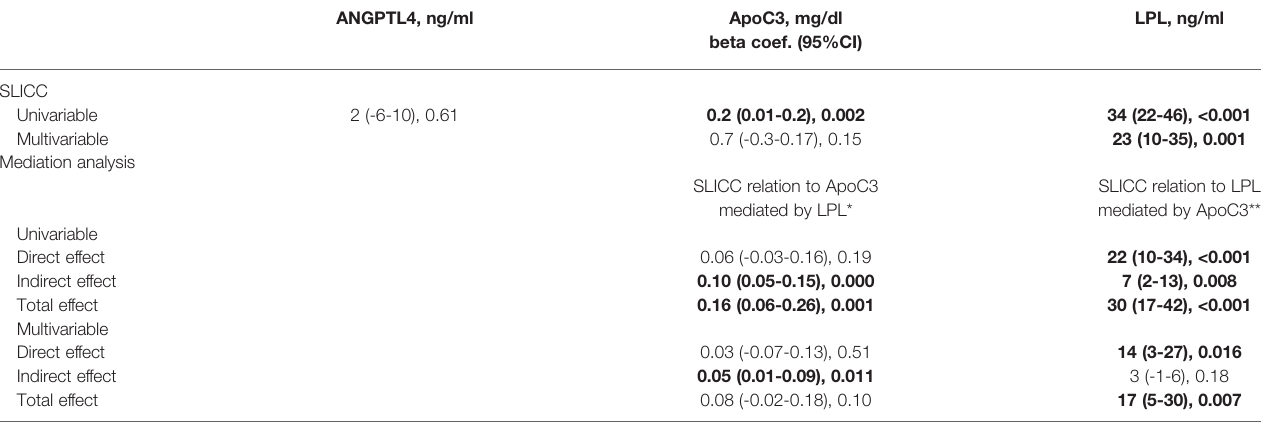
TABLE 5 | Disease damage relationship with triglycerides metabolism molecules.